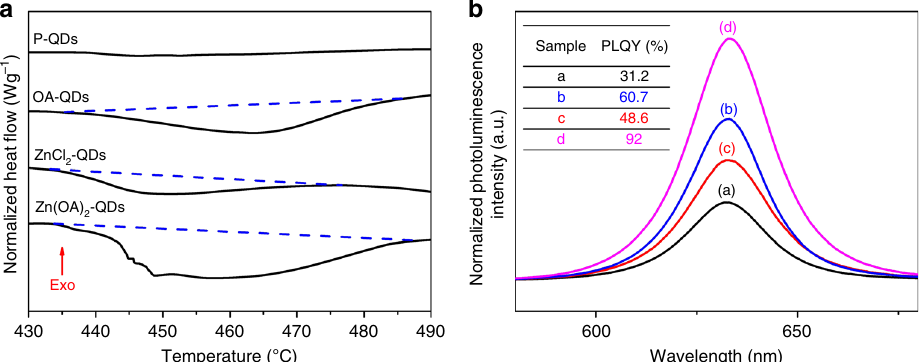
Fig. 4 The signi fi cance of surface ligands passivation on quantum dots. a Differential scanning calorimetry measurement for all kinds of ligand coated quantum dots. Upper direction, as marked by the arrow, represents exothermal heat fl ow. b Photoluminescence intensity of all kinds of ligand coated colloidal quantum dots. a P-QDs, b OA-QDs, c ZnCl 2 -QDs, and d Zn(OA) 2 -QDs. Inserted table shows the photoluminescence quantum yield of all colloidal quantum dots in octane.